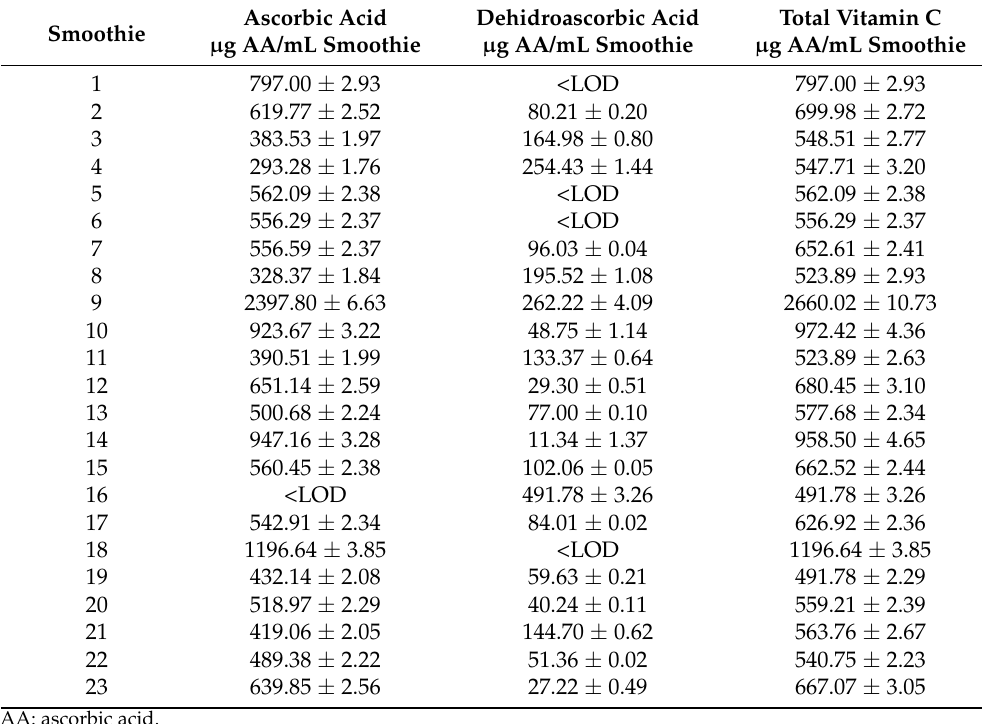
Table 4. Additionally, Figure 2 shows the typical chromatogram of the determination of vitamin C (peak at 5.5 min) by HPLC-UV/VIS in the smoothies. Table 4. Vitamin C content of the smoothies analyzed by HPLC-UV/VIS expressed as average ± standard deviation.